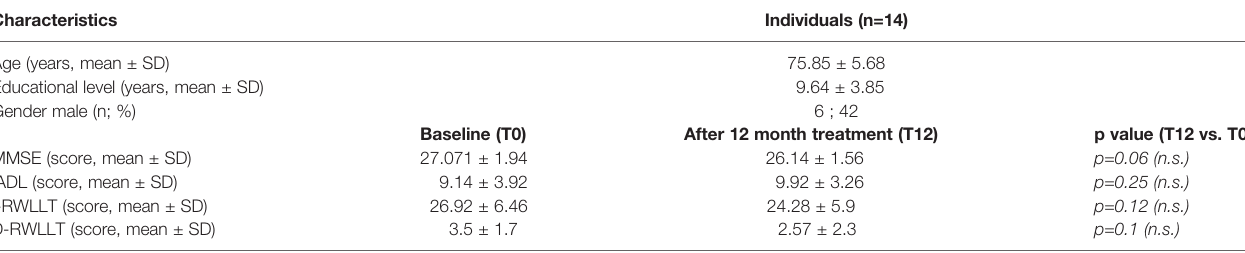
TABLE 1 | Sociodemographic and clinical characteristics of amnestic MCI patients.